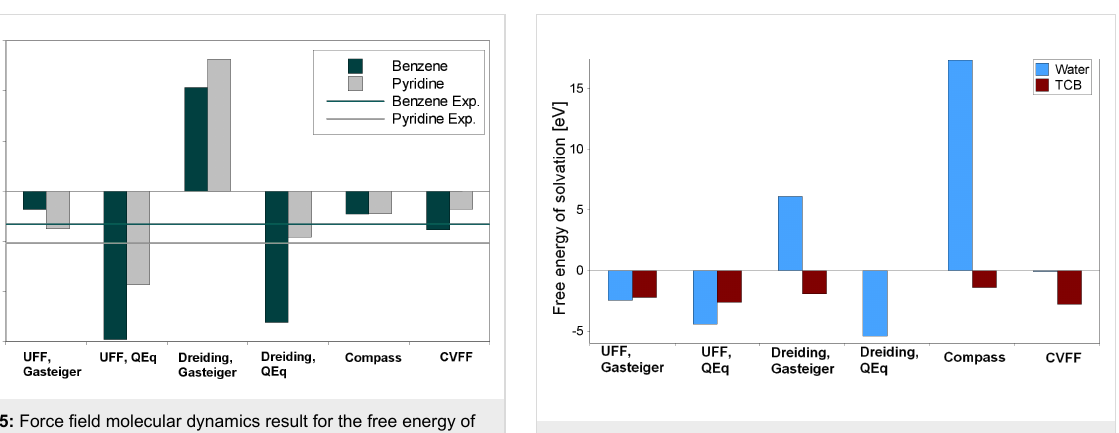
Figure 6: Force-field molecular dynamics result for the free energy of solvation E solv for 3,3 ′ -BTP in water and TCB.